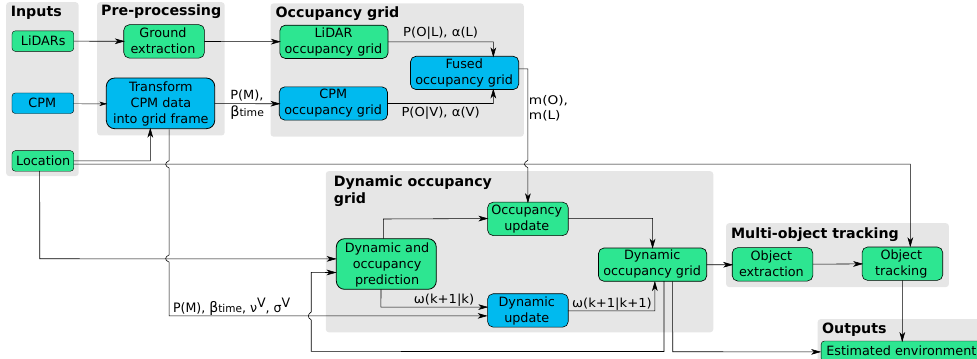
Figure 2. Inclusion of the CPM’s data into the perception